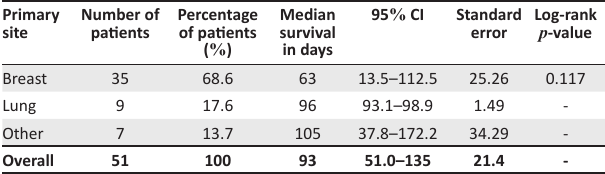
TABLE 2: Survival statistics of patient sample by primary site. Primary site